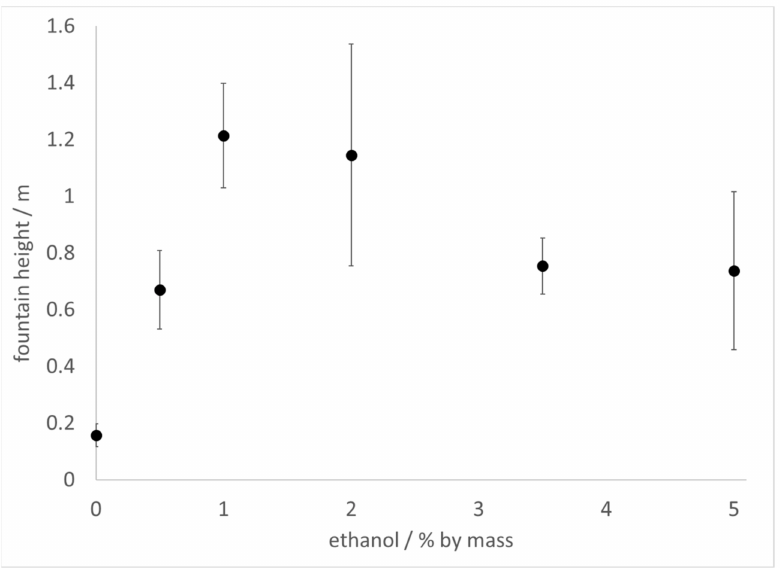
Figure 1. Fountain heights achieved when 2 L of sparkling water is treated with increasing amounts of ethanol as indicated in the text and then 11 mint Mentos are added at 20–21 ◦ C. Error bars represent one standard deviation.